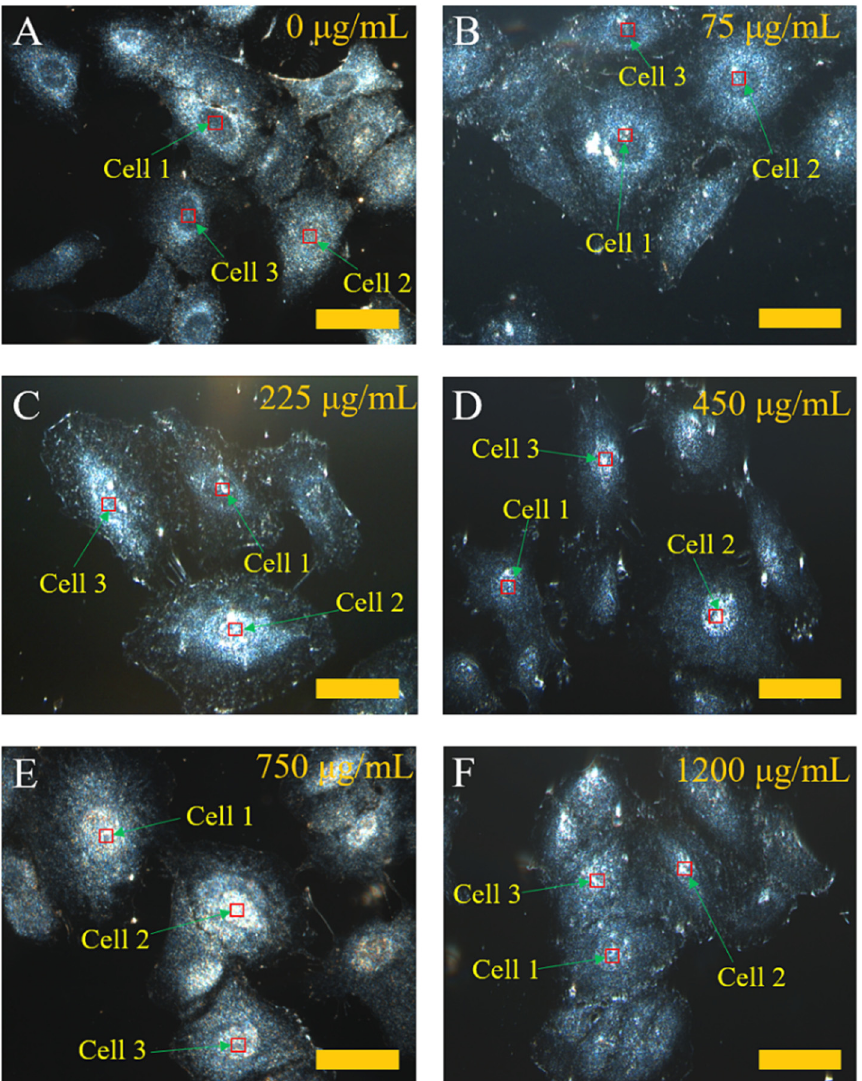
Figure 5. Dark-field images of cells incubated without CNDs ( A ) or with CNDs for 24 h using different concentrations ranging from 75 µg/mL to 1200 µg/mL ( B – F ). All the scale bars are 4 µm.